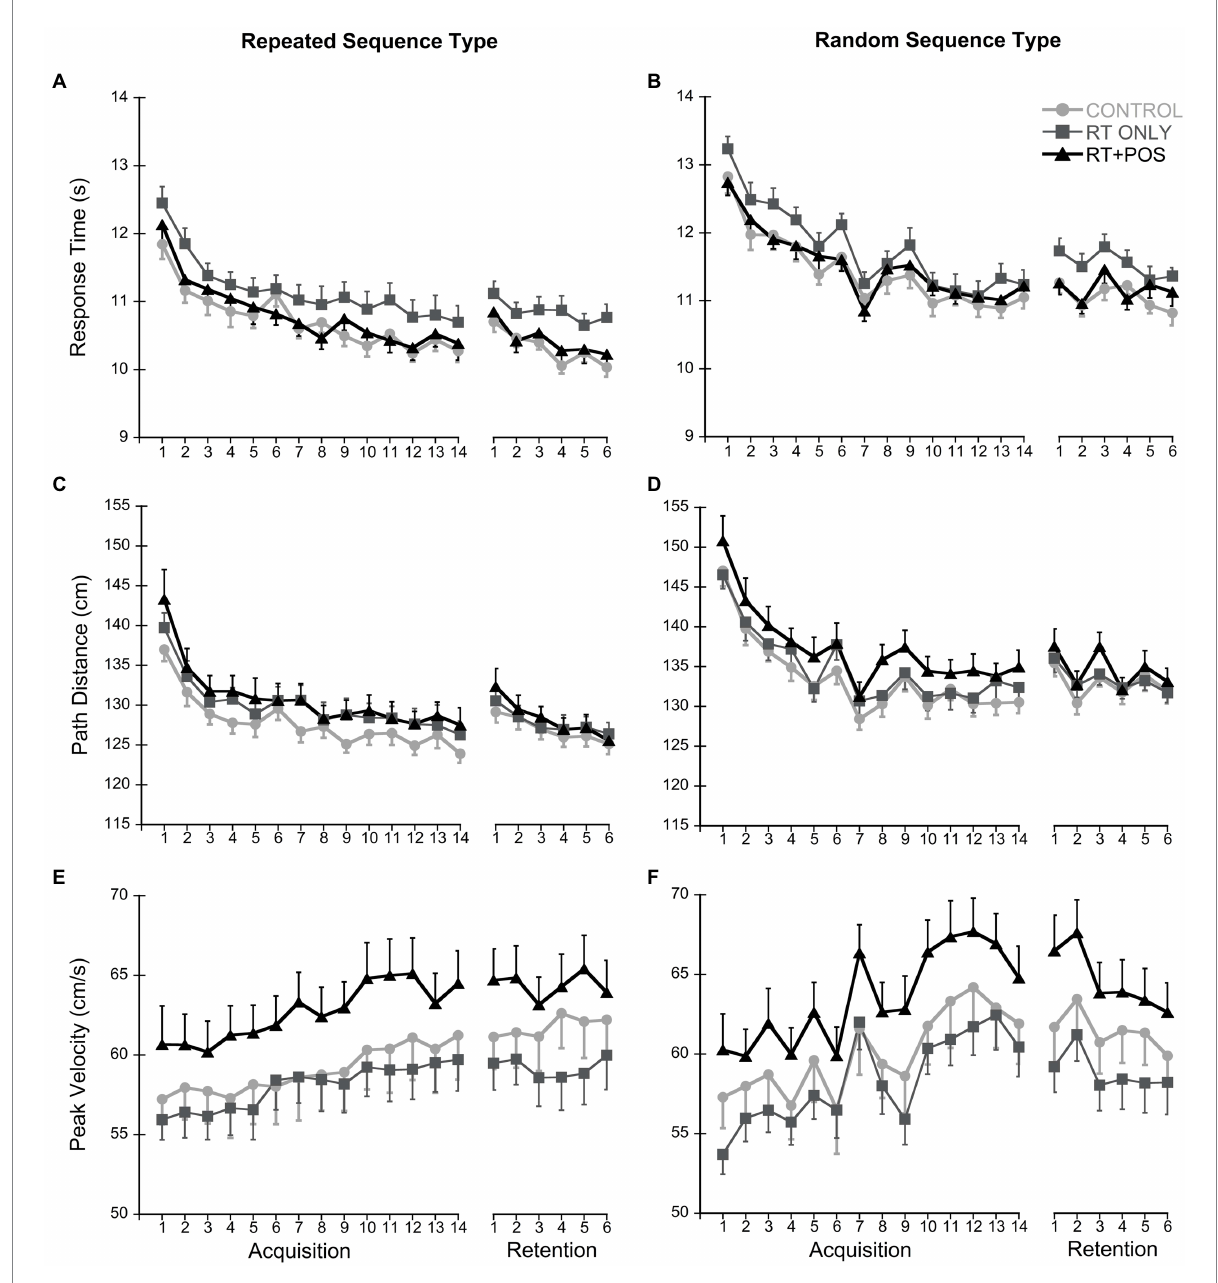
FIGURE 3 Motor performance variables during Acquisition and Retention. Each data point is the average ± standard error of 5 sequence trials. (A) Response time for the repeated sequence; (B) Response time for the random sequence; (C) Path distance for the repeated sequence; (D) Path distance for the random sequence; (E) Peak velocity for the repeated sequence; (F) Peak velocity for the random